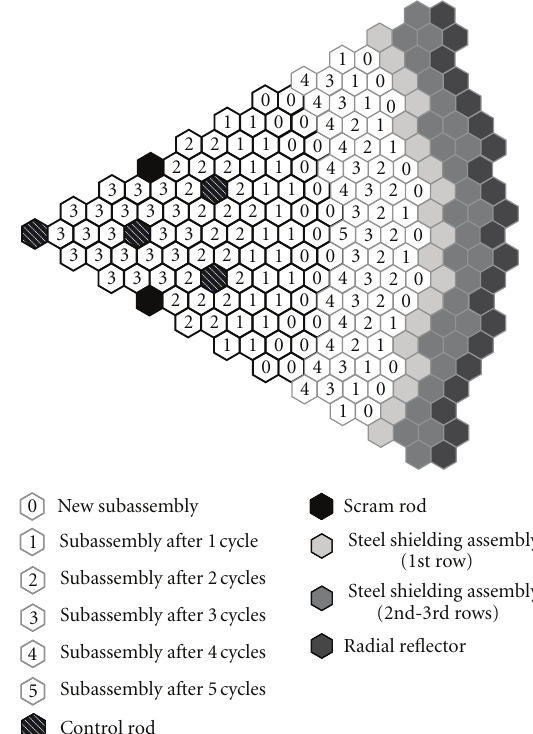
Figure 5: The loading pattern of fuel assemblies in the fast